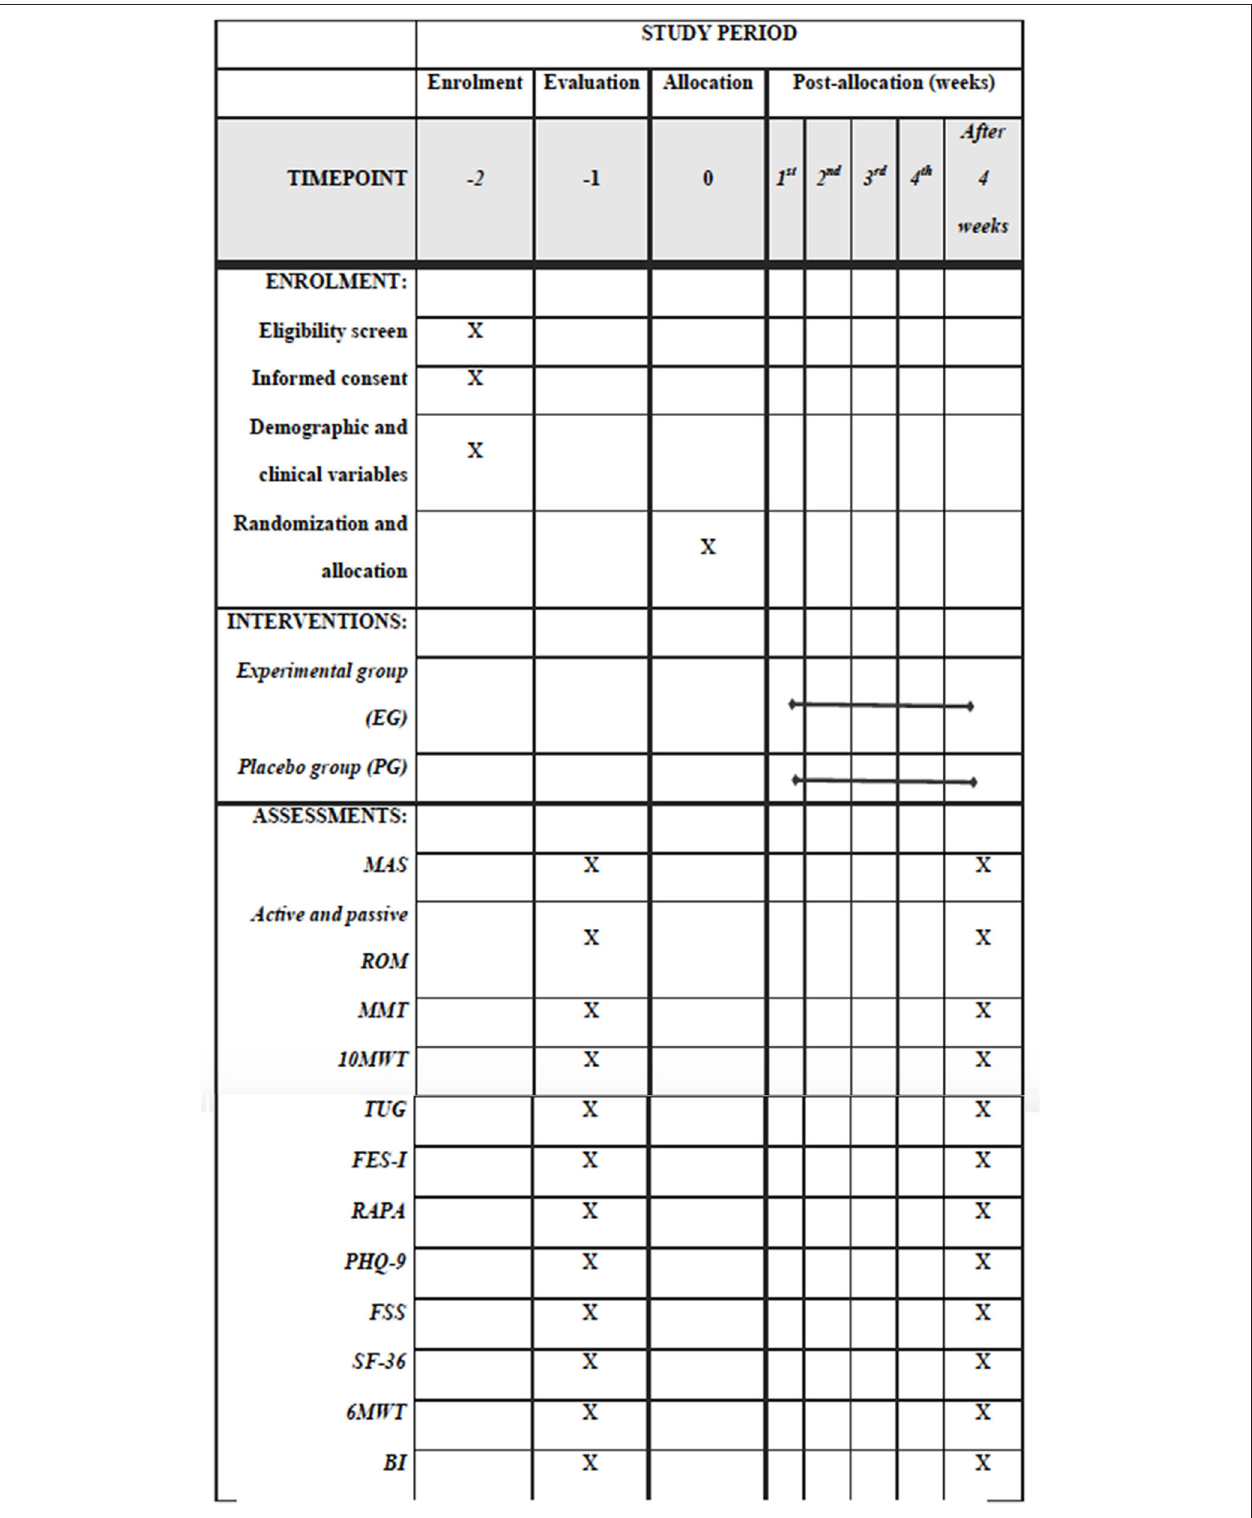
FIGURE 1 | Standard Protocol Items: Recommendations for Interventional Trials (SPIRIT) for the content of the schedule of enrolment, interventions, and assessments checklist.